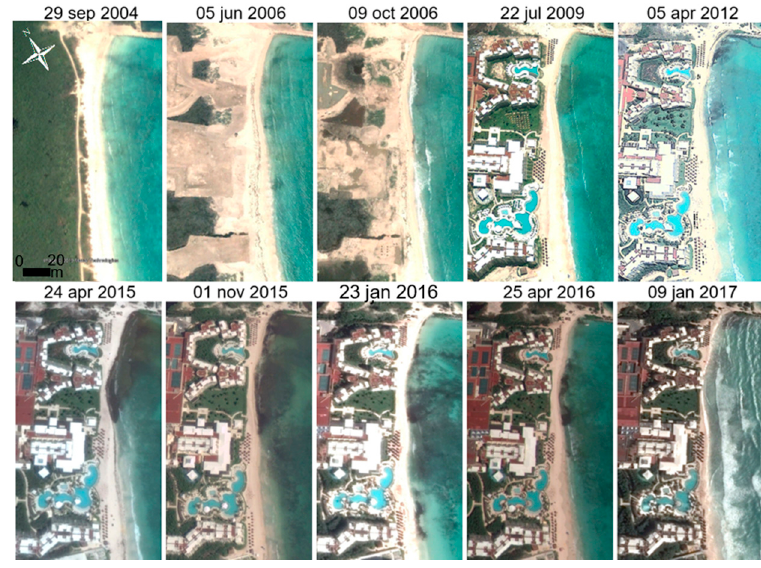
Figure 4. Evolution of the dry beach from 2004 to 2017 (Source: Google Earth).